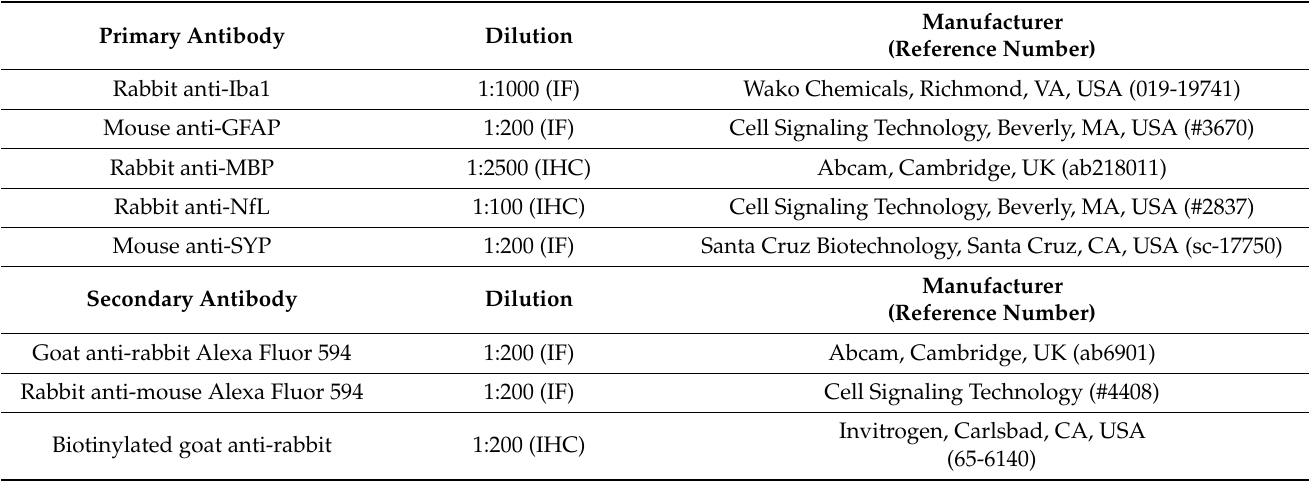
Table 1. List of antibodies used for the immunofluorescent (IF) and immunohistological (IHC) analyses. Primary